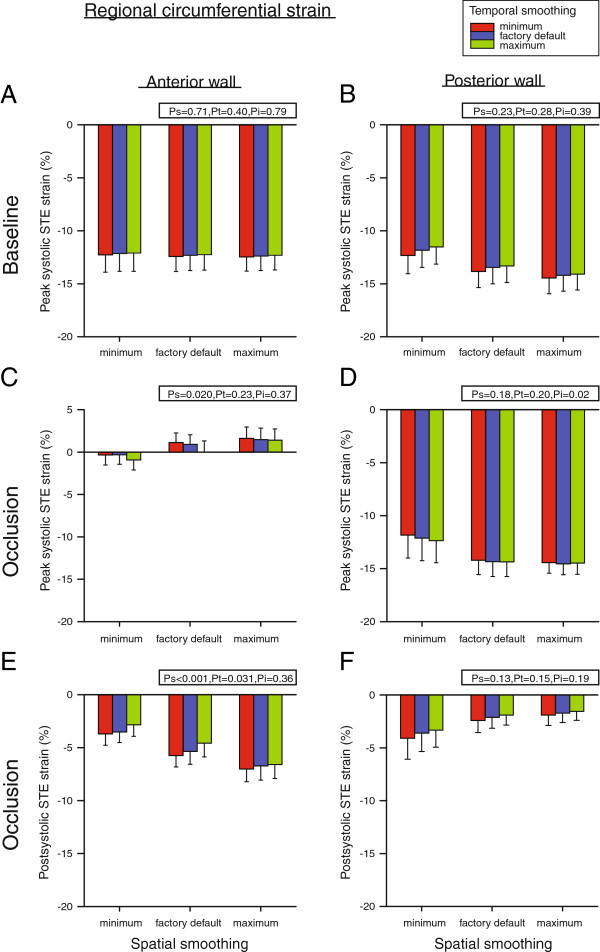
Regional circumferential peak- and postsystolic Speckle Tracking Echocardiography (STE) strain in the anterior and posterior myocardial wall at baseline (A and B) and after left anterior descending coronary artery occlusion (C - F). Measurements were performed with nine different combinations of spatial and temporal smoothing created by setting these parameters in turn to minimum, factory default and maximum. Mean values of seven animals, error bars represent SEM. Ps, Pt and Pi as defined in Figure 4.